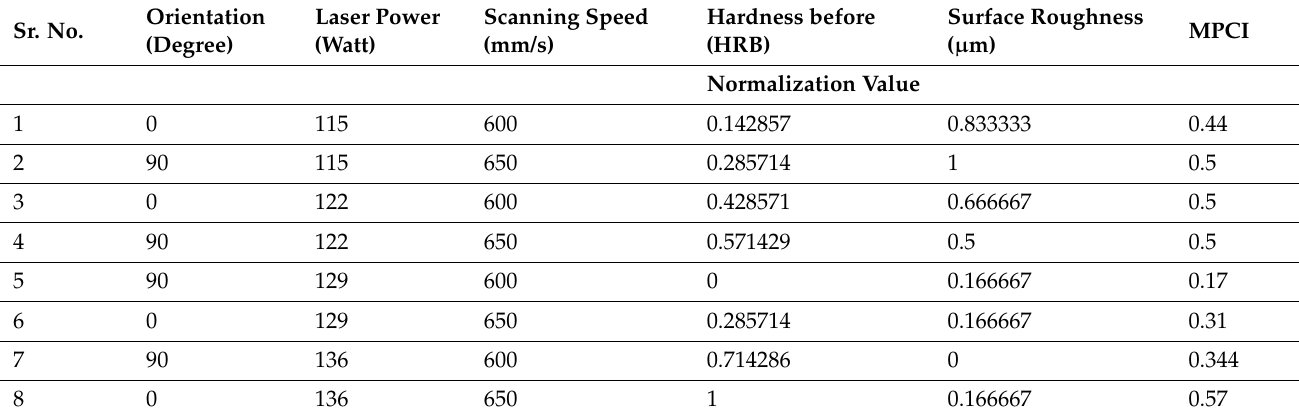
Table 4. L 8 Normalizing value for hardness and surface roughness.